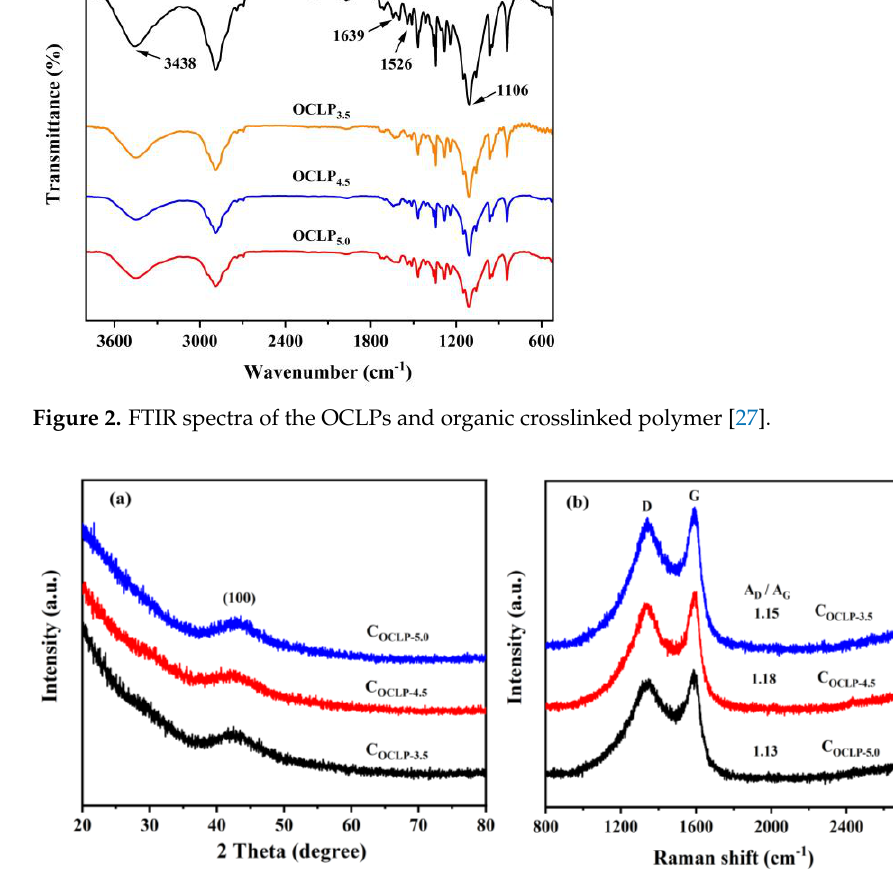
Figure 2. FTIR spectra of the OCLPs and organic crosslinked polymer [27].